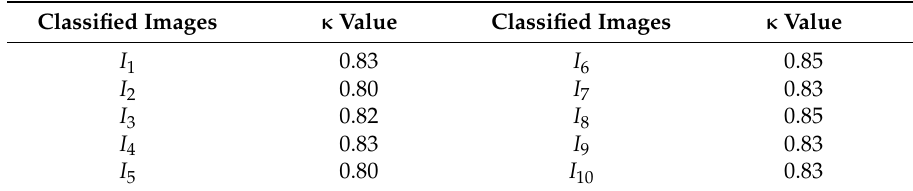
Table 5. The accuracy assessment results after thresholding at thresholds d = 0.5 for the whole study